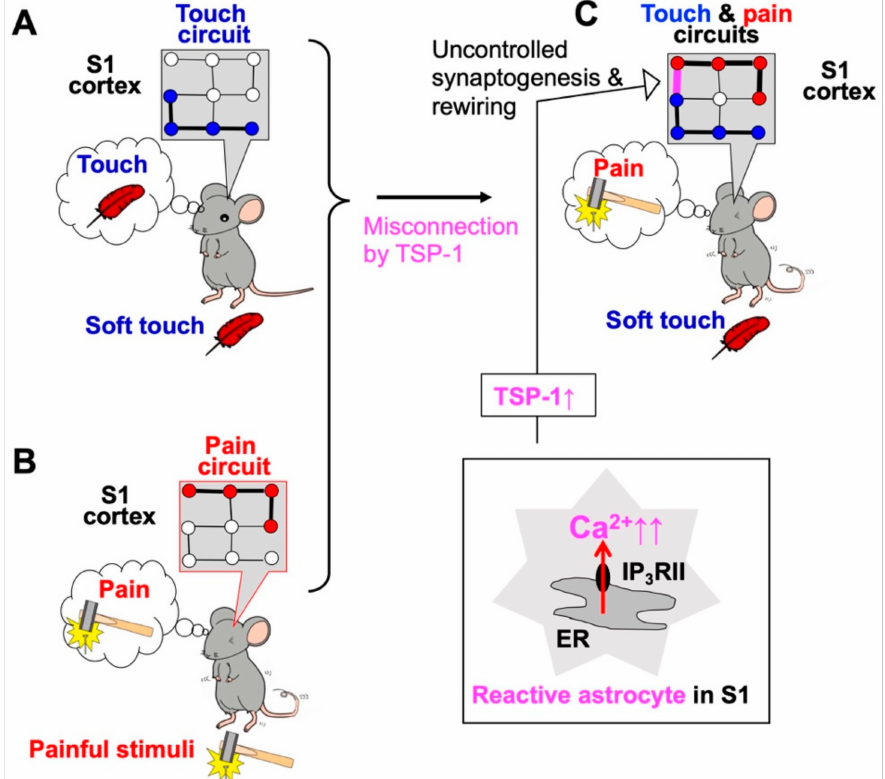
Figure 1. Abnormal Ca 2+ signals in primary somatosensory (S1) cortex astrocytes cause neuropathic pain and allodynia. Soft touch stimulation ( A ) and pain stimulation ( B ) activate touch circuits and pain circuits, respectively. In a model of neuropathic pain induced by sciatic nerve ligation, S1 astrocytes become reactive and exhibit excess Ca 2+ signaling via type II inositol 1,4,5-trisphosphate receptors (IP 3 RII) ( C ). Reactive astrocytes in the S1 cortex produce synaptogenic molecules such as thrombospondin-1 (TSP-1) and cause excessive, uncontrolled synaptogenesis and network rewiring of S1 circuits ( C , arrow), thereby leading to mechanical